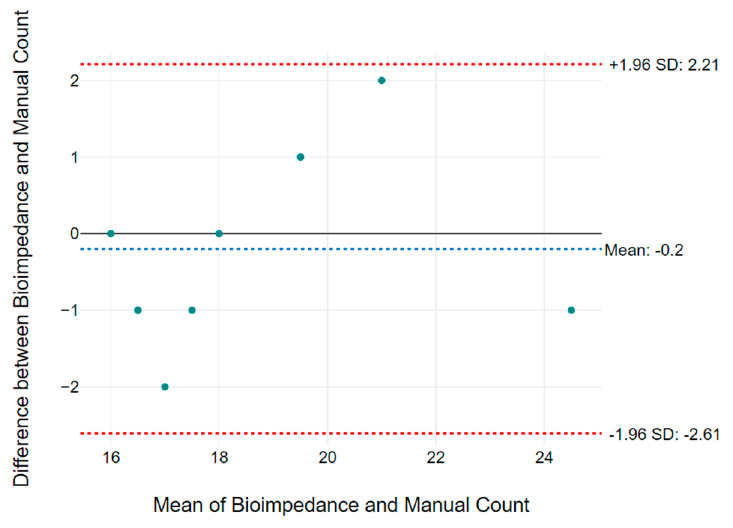
Figure 17. Bland Altman plot based on bioimpedance measured vs. manually counted RR values listed in Table 2.